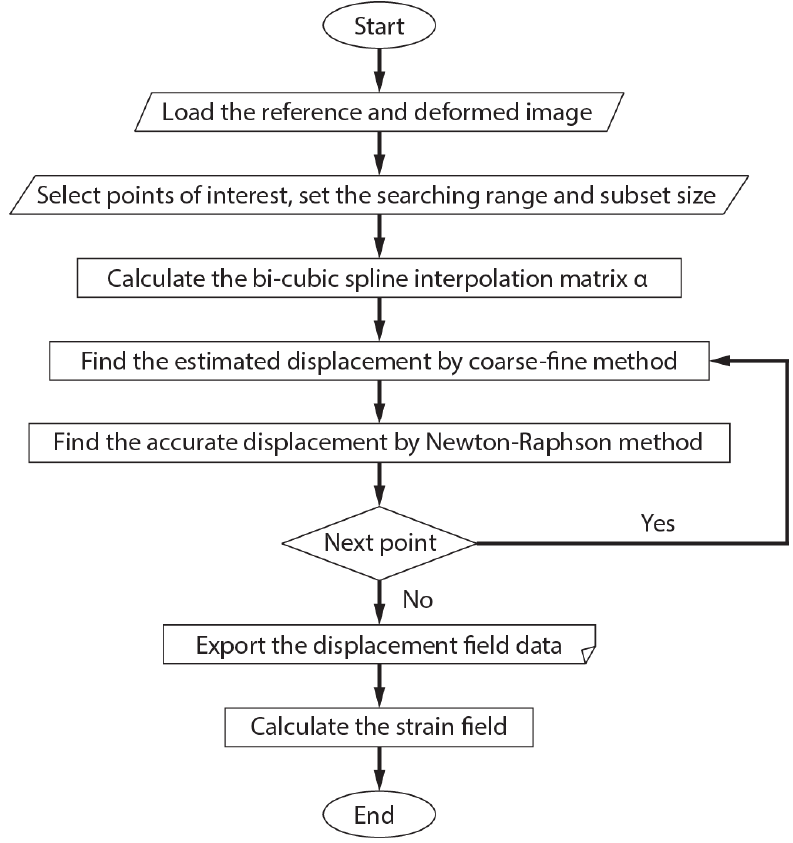
Figure 8. Flow chart of the DIC method.